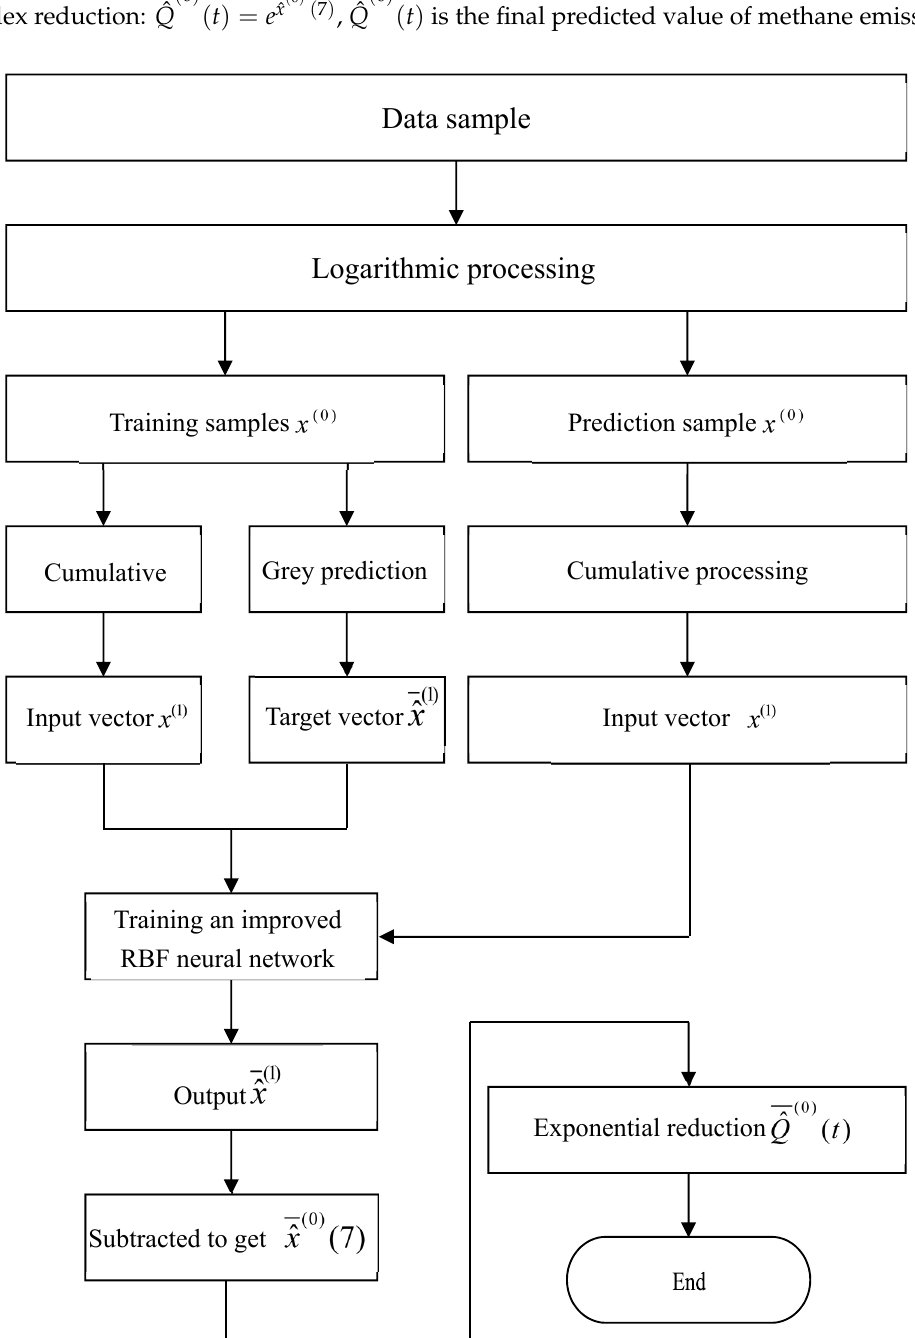
Figure 3. Improved grey RBF neural network modeling and prediction process.